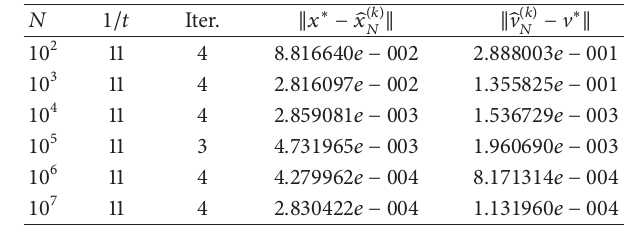
Table 2: The numerical results for Example 2. Table 3: The numerical results for Example 3.